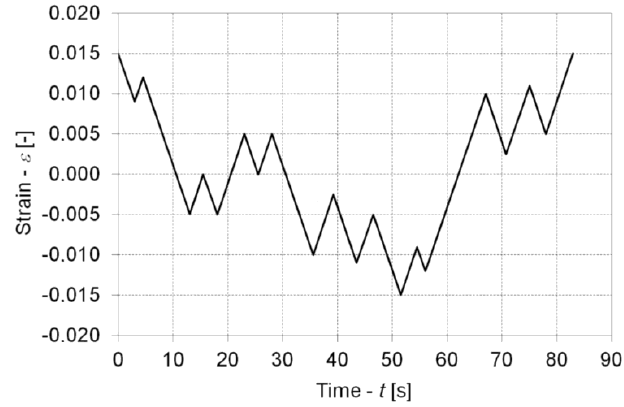
Figure 4. Strain time series for the first random-loading experiment.